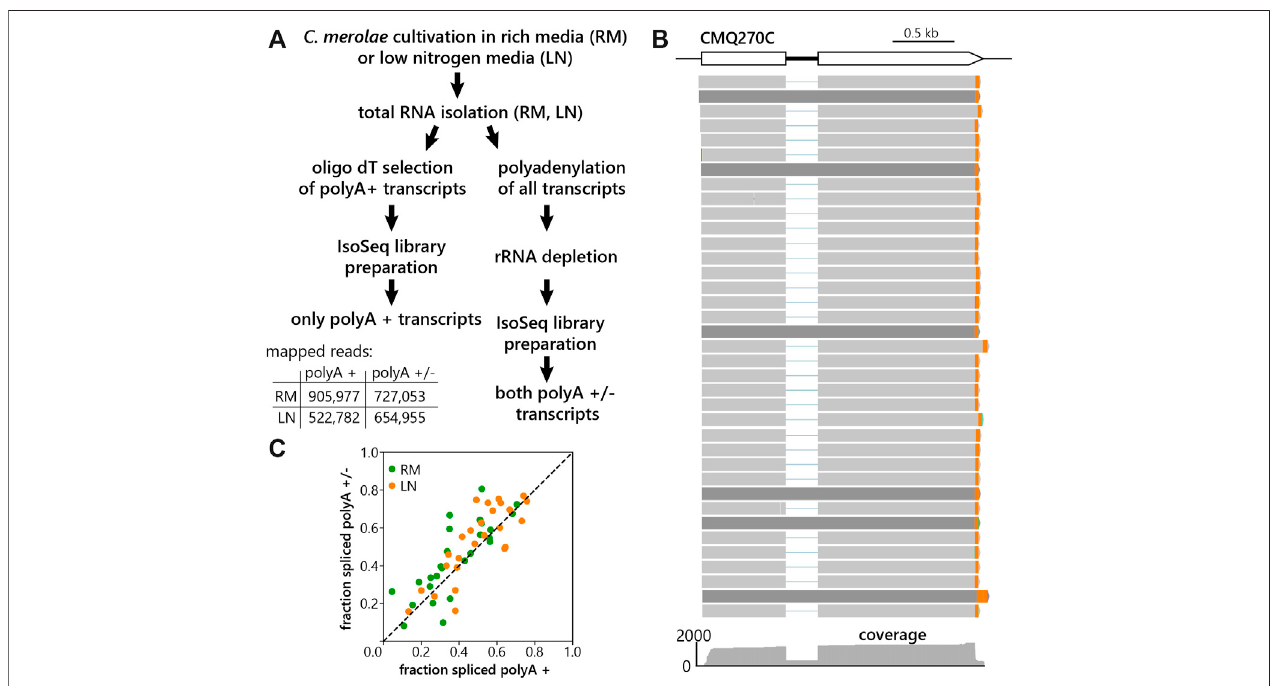
FIGURE1| Long-read sequencingof C.merolae polyA+ and polyA- RNA. (A) Work fl owoftheexperiment withindicated numbers ofmapped readsresultingfrom individuallibrarypreparations. (B) Longreadsalignedtothereferencegenome,usingtheintron-containinggeneCMQ270asanexample.3 ′ -endsaremarkedinorange. (C) Correlation of fraction of spliced reads obtained from the polyA+ and polyA+/ − libraries prepared from the RM (rich media, green) and LN (low nitrogen, orange) samples of C. merolae. Fraction spliced was calculated asthe number of intron-spanning reads which were spliced divided bythe total number ofintron-spanning reads for each gene shown. Pearson ’ s correlation (cid:1) 0.80 (RM), 0.82